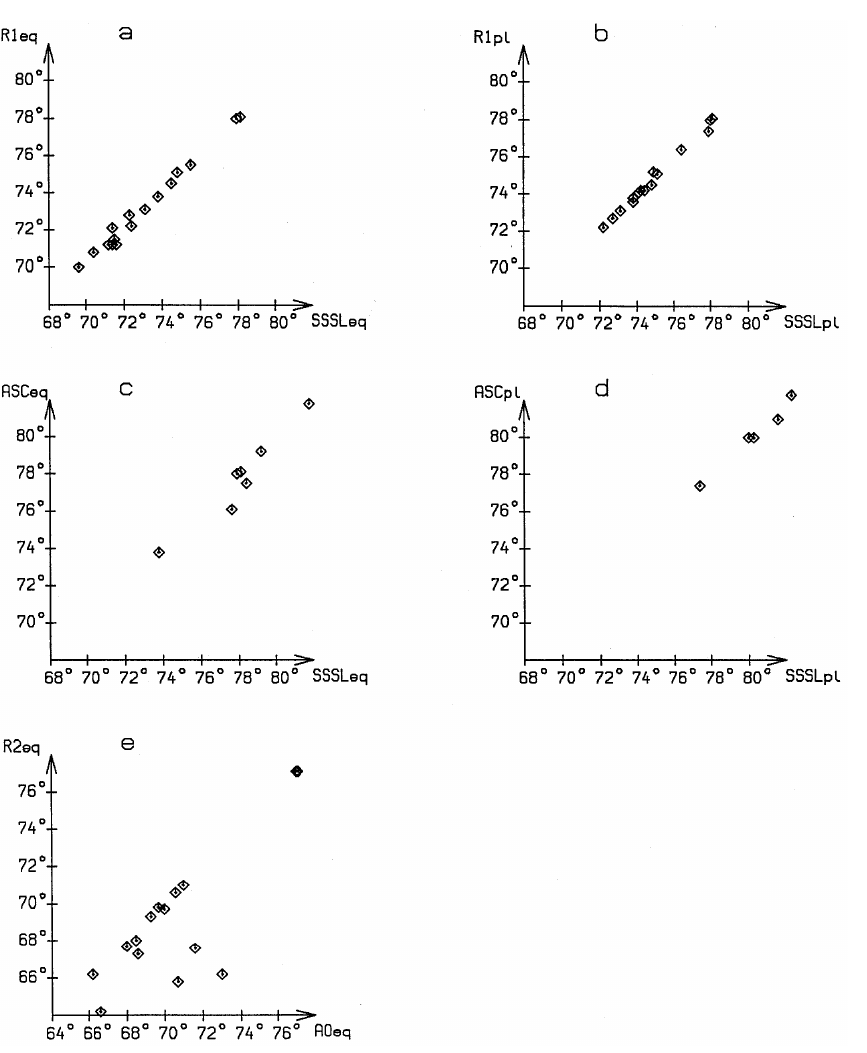
Fig. 15. Comparison of the loca- tion of plasma regime boundaries, field- aligned currents and convection rever- sals in the dawn sector, based on the DMSP and Viking observations: (a) SSSL eq and R 1 eq ; (b) SSSL pl and R 1 pl ; (c) SSSL eq and ASC eq ; (d) SSSL pl and ASC pl ; (e) AO eq and R 2 eq